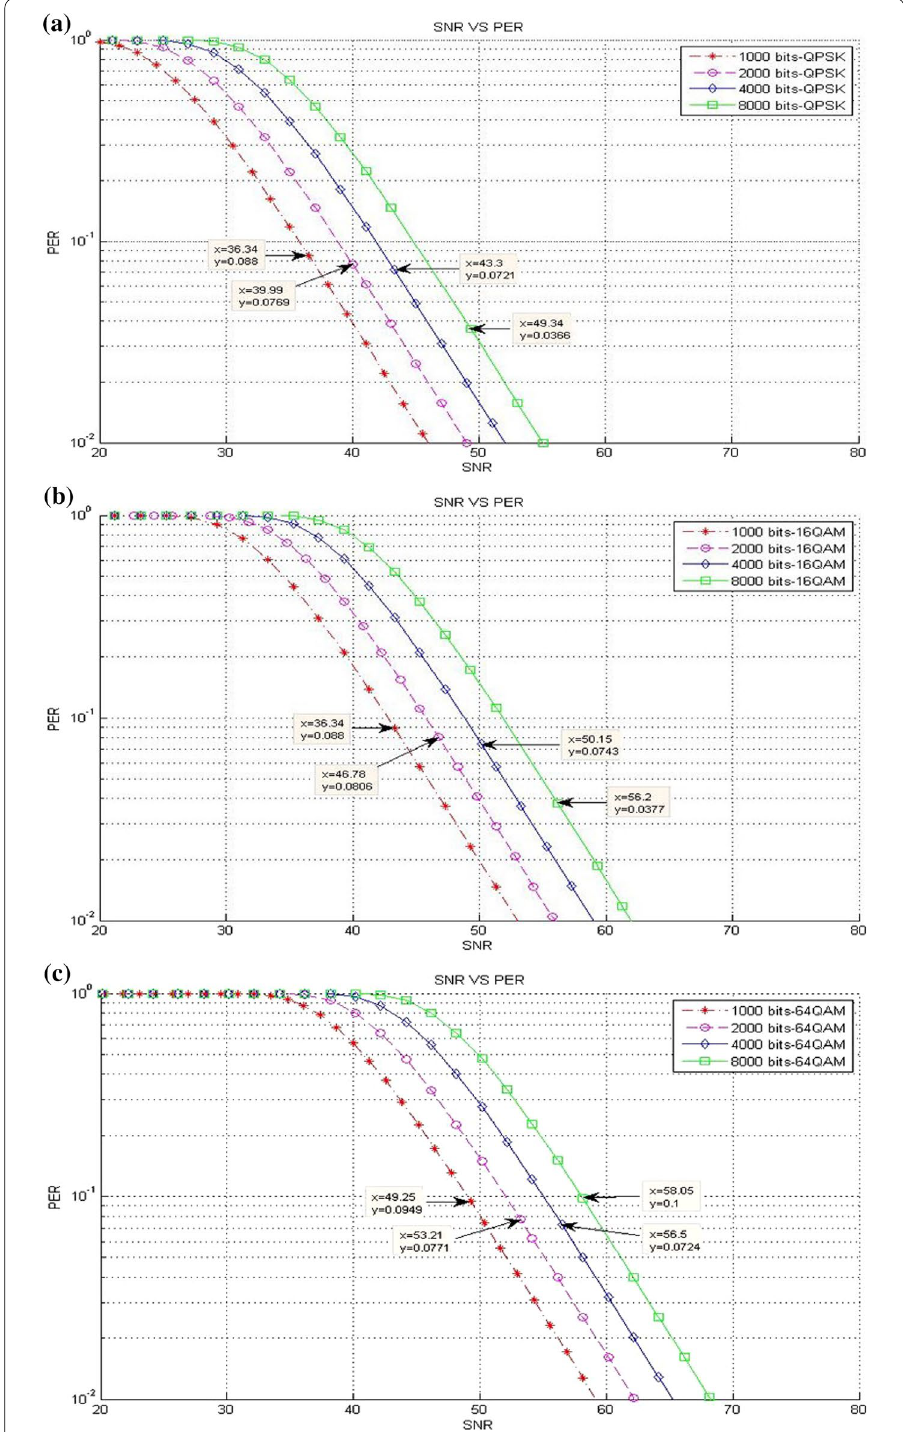
Fig. 11 a QPSK, b 16‑QAM, c 64‑QAM ( a – c packet loss of SNR threshold values for different modulation types and various packet sizes in the existing LTE system